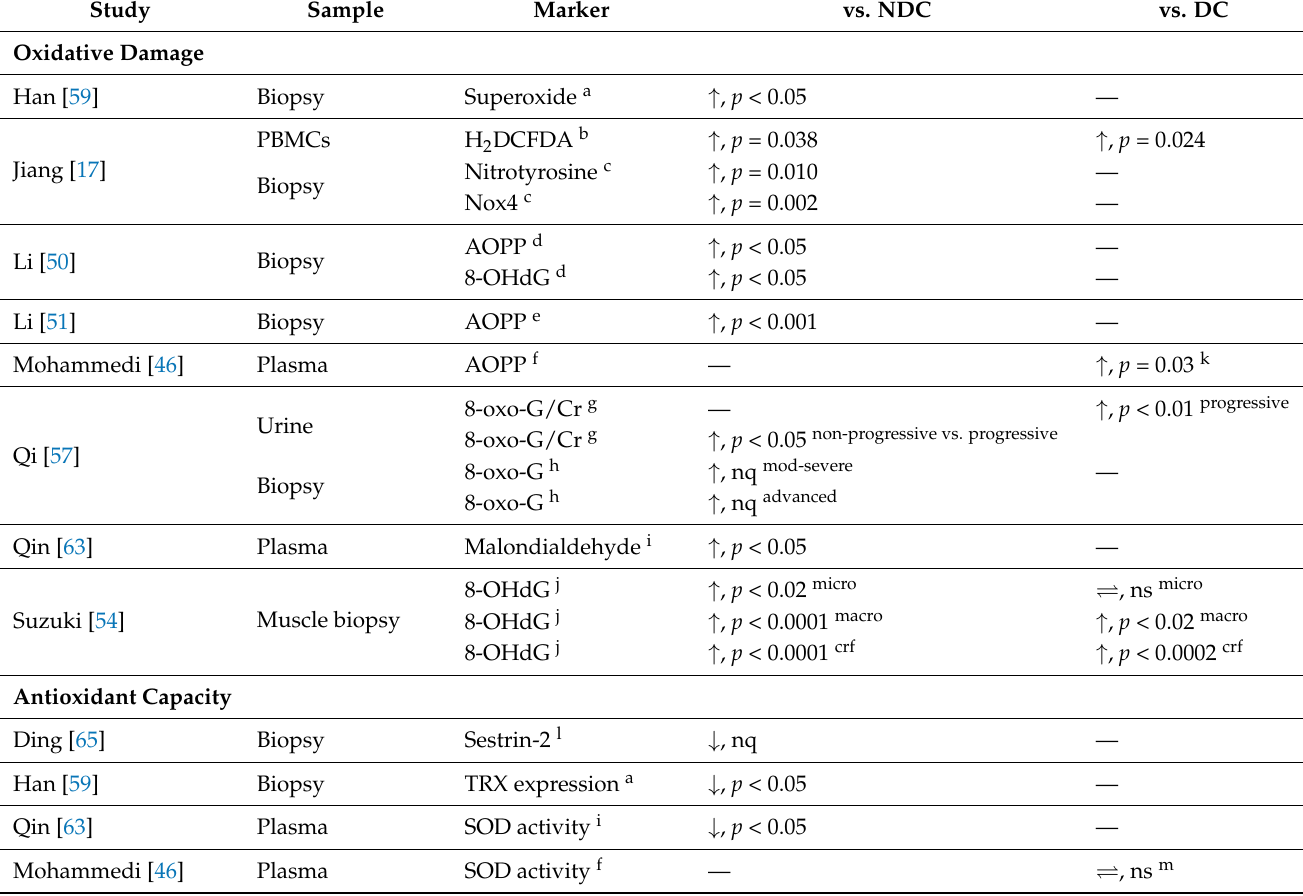
Table 4. Summary of oxidative damage and antioxidant profile in individuals with DKD compared to NDC and/or